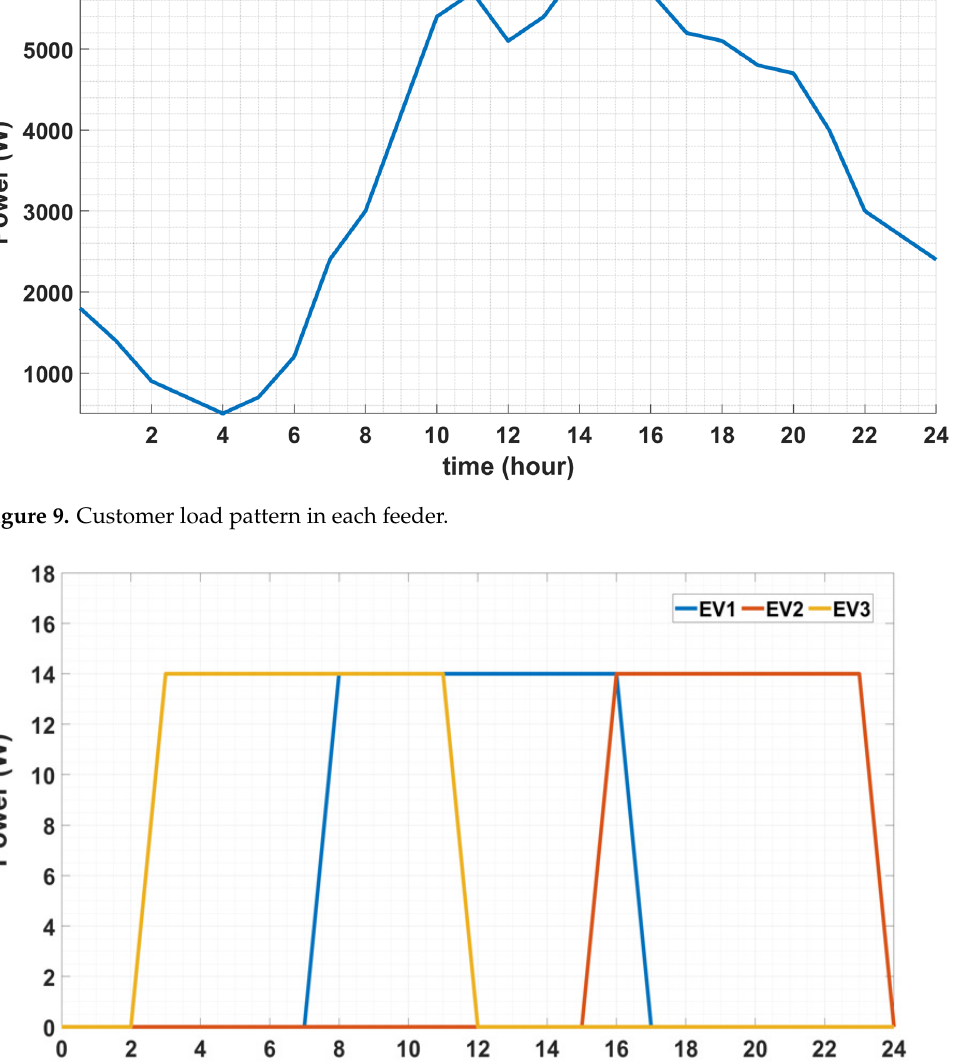
Figure 10. EV charging patterns in each